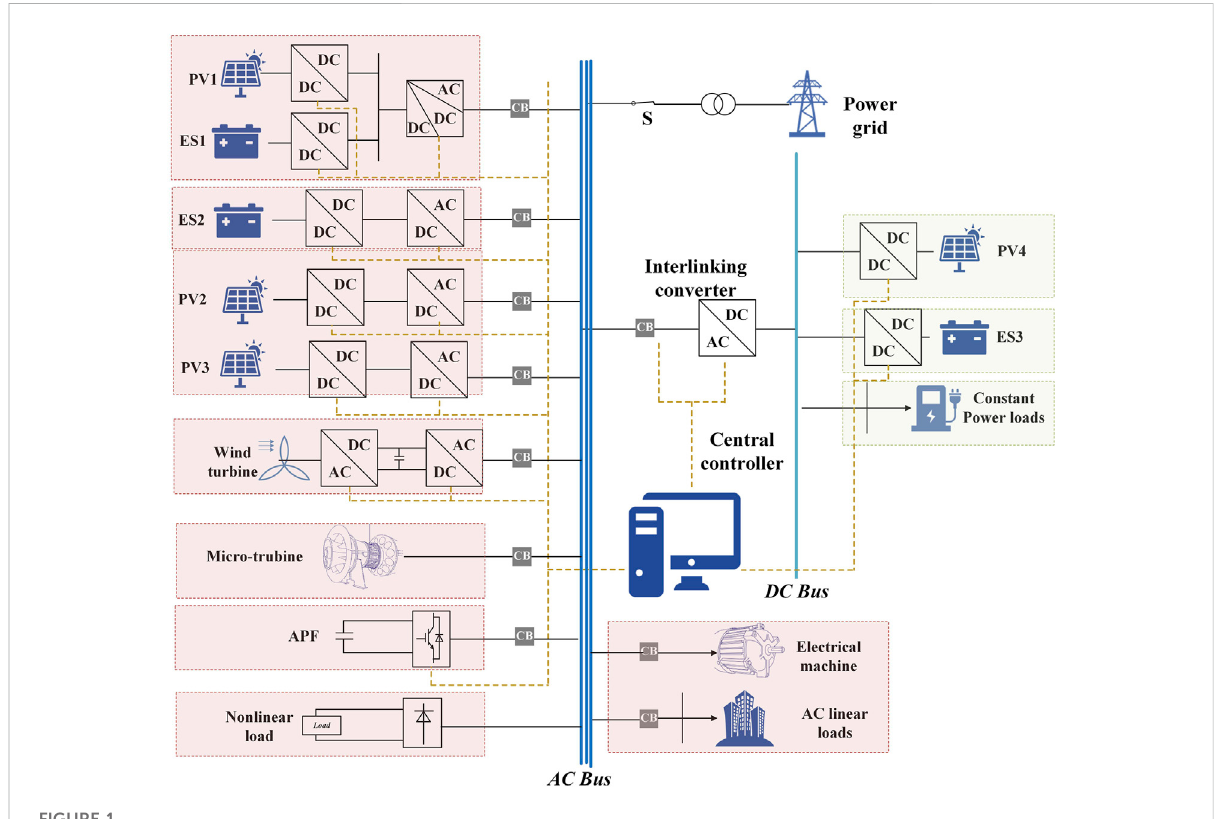
FIGURE 1 The prosumer ’ s